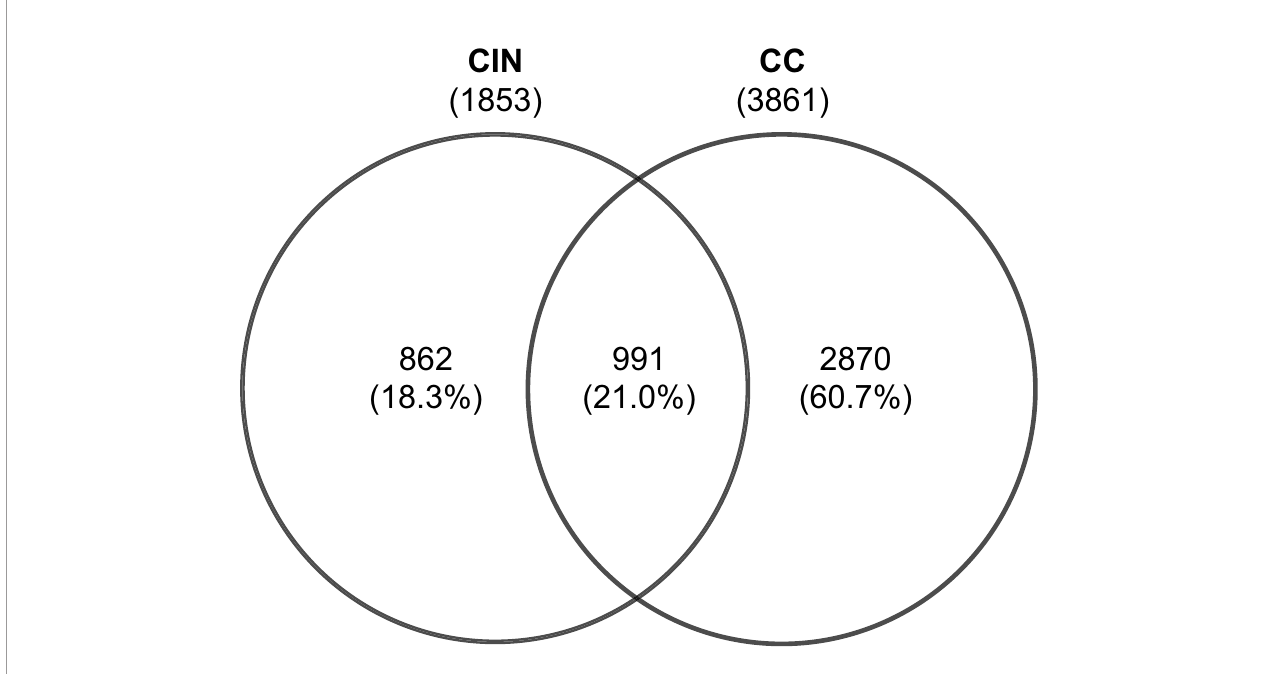
FIGURE 2 | Venn diagram of the differentially expressed genes from cervical epithelial samples in patients with CIN and CC. Values are numbers unless otherwise stated. CC, Cervical cancer; CIN, Cervical intraepithelial